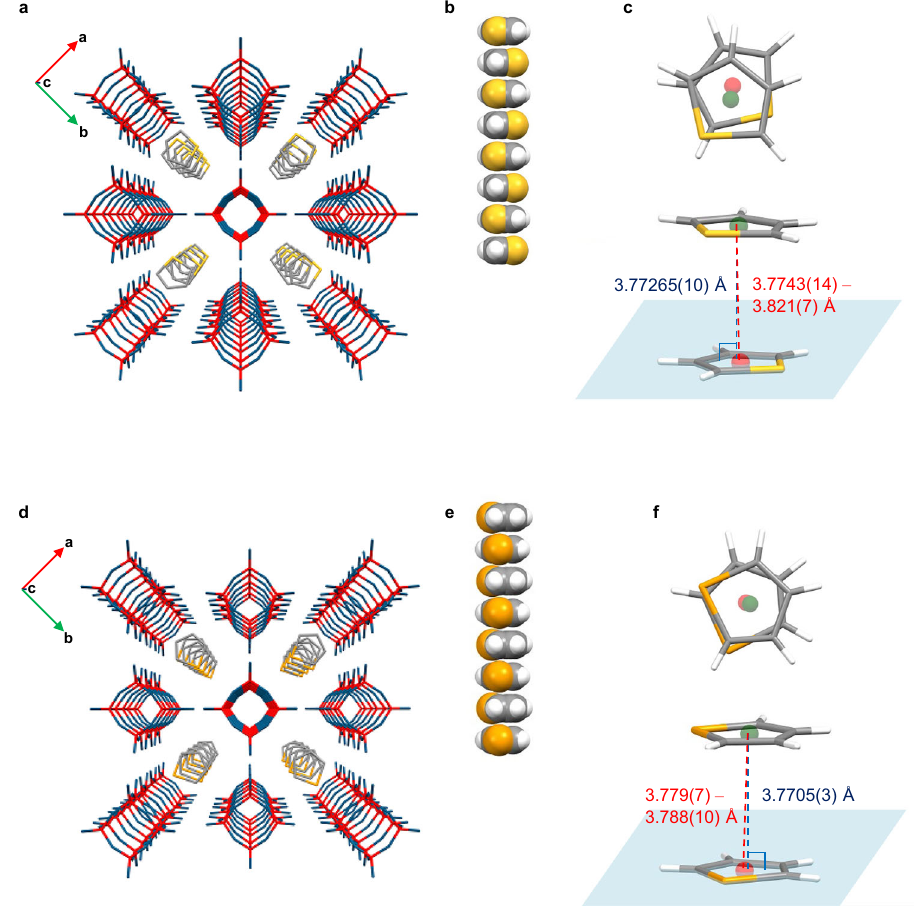
Fig. 6 Crystal structures of 3D crystals encapsulating heteroaromatic molecules. Crystal structures of 3D ⊃ thiophene ( a – c ) and 3D ⊃ selenophene ( d – f ) determined by single-crystal X-ray diffraction. The orientation of the guest molecules in 3D ⊃ thiophene and 3D ⊃ selenophene was disordered, and a representative orientation is shown for clarity. The hydrogen atoms in the 3D crystal packing representations have been omitted for clarity. Color code: Si = red; O = blue; C = gray; H = white; S = yellow; Se = orange. The green and red points are the centroids of the guest molecules, and the light blue plane passes through a guest molecule. The dashed line color scheme is as follows: a line connecting the centroids of two guests: red; line vertically connecting a centroid to the molecular plane of another guest: blue. a , d 3D crystal packing; b , e partial space- fi lling views of the stacked guest molecules; c , f top view and diagonal view of the geometry of the stacked guest